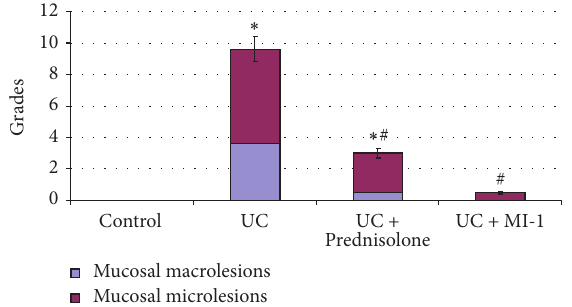
Figure 4: Bowel injury for rats experiencing UC and treated with Prednisolone and MI-1. ∗ 𝑝 ≤ 0.05 compared with control group; # 𝑝 ≤ 0.05 compared with UC group.